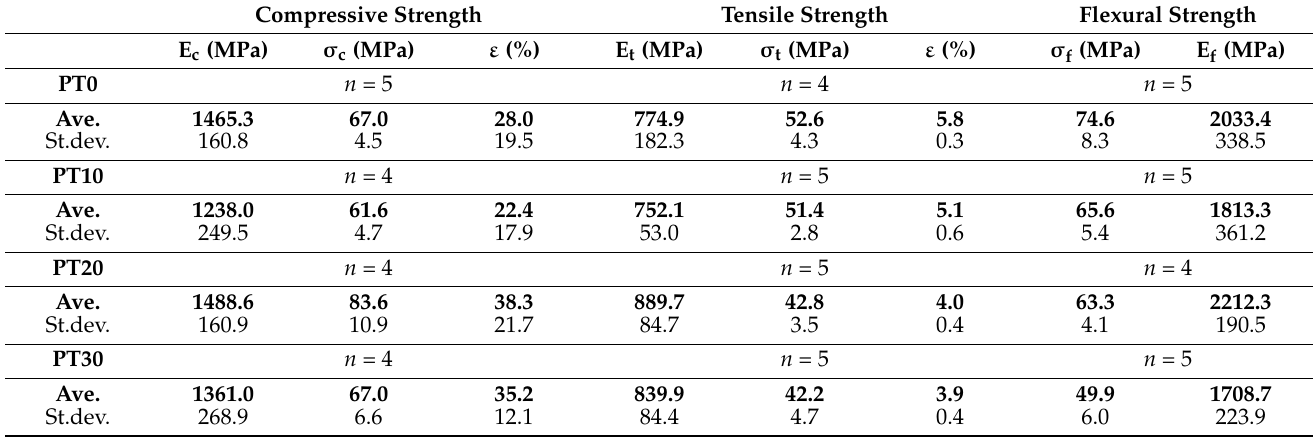
Table 4. Results of mechanical tests (compressive, tensile, and flexural strengths) for the PT samples. Compressive Strength Tensile Strength Flexural Strength